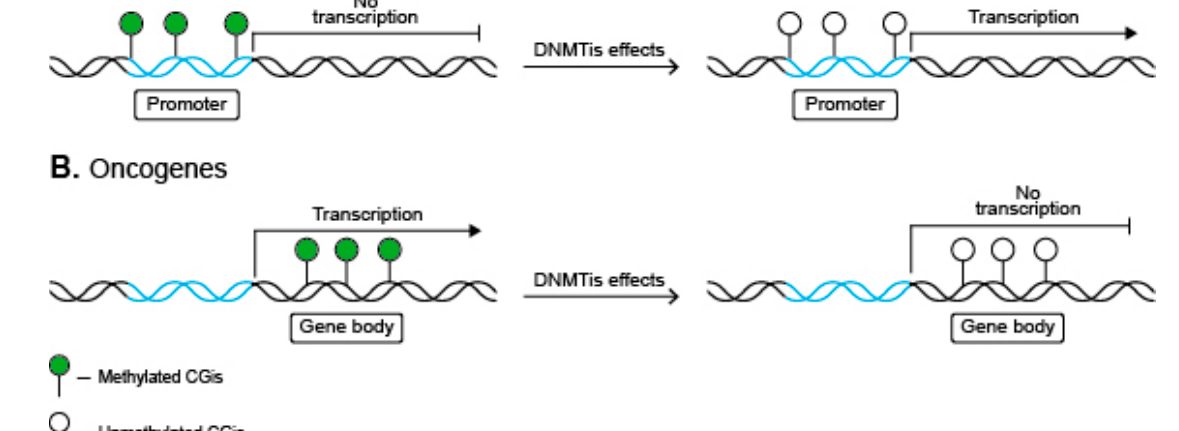
Figure 2. Major DNMTis effects on MB cells. ( A ) The transcription of TSGs is induced by DNMTi-dependant hypomethyla- tion of the gene’s promoter. Encoded proteins regulate cell proliferation. ( B ) In contrast, DNMTi-induced hypomethylation of the gene’s body stops the translation process. In the case of oncogenes, which encode proteins that induce cell proliferation, such hypomethylation induces